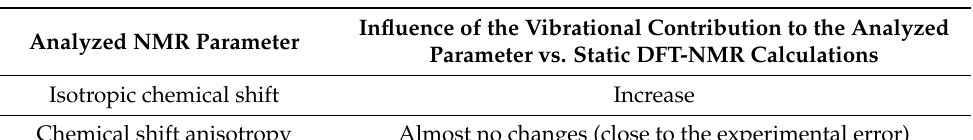
Table 2. Influence of the vibrational contribution to the analyzed NMR parameter vs. static DFT-NMR calculations